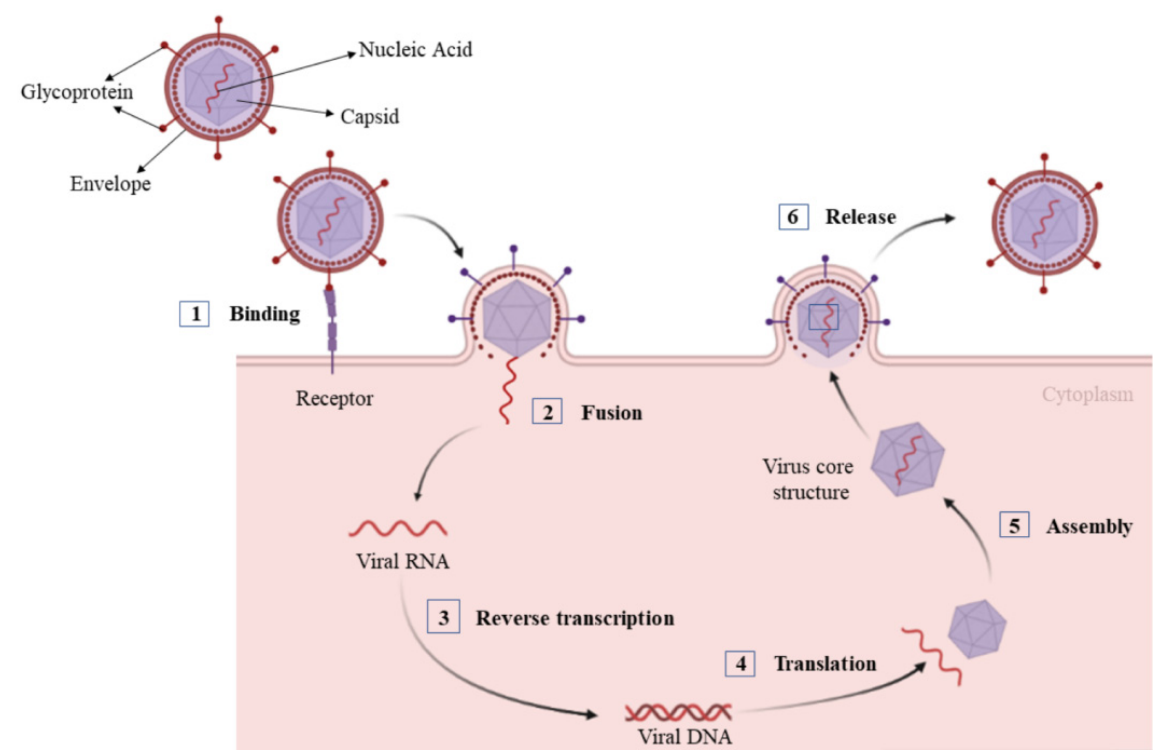
Figure 1. Steps in the viral replication cycle.